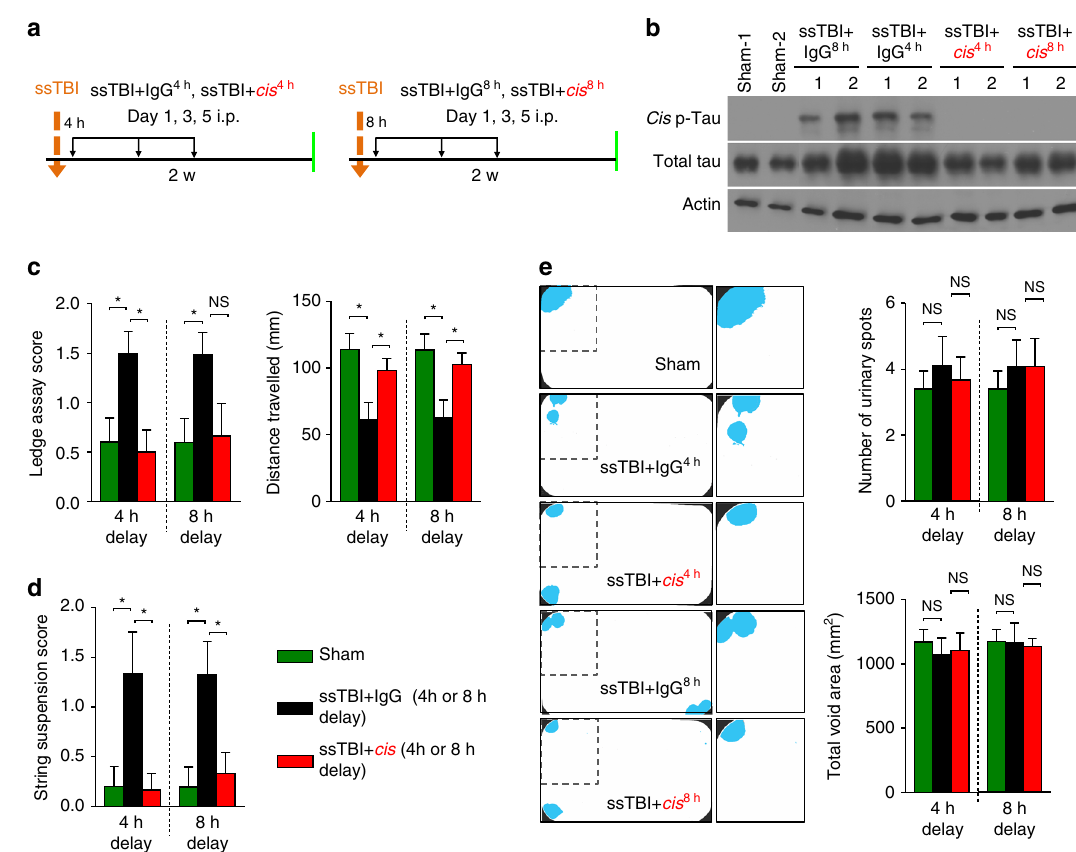
Fig. 6 Treating ssTBI mice with 3 i.p. cis mAb with 4 or 8 h delay eliminates cis P-tau and restores sensorimotor coordination de fi cits at 2 weeks after injury. Treating ssTBI mice with 3 i.p. of cis mAb even with 4 or 8 h delay a effectively eliminated cis P-tau induction b , and restored sensorimotor coordination de fi cits (ledge assay and string suspension assay) c , d . Urinary incontinence was not observed after 2-weeks e . Orange arrows, ssTBI; black arrows, antibody injection; green arrows, functional, or pathological assays. The data were presented as means ± SEM. The p -values were calculated using unpaired two-tailed parametric Student ’ s t -test. * p < 0.05, NS, not signi fi